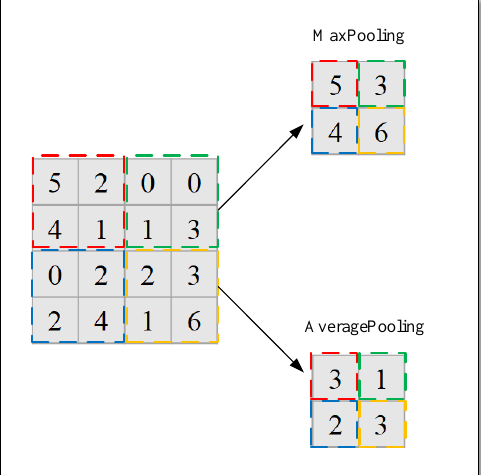
Figure 3. Two forms of pooling ways. MaxPooling takes the maximum value among the four dotted box and AveragePooling takes the average value. box and AveragePooling takes the average